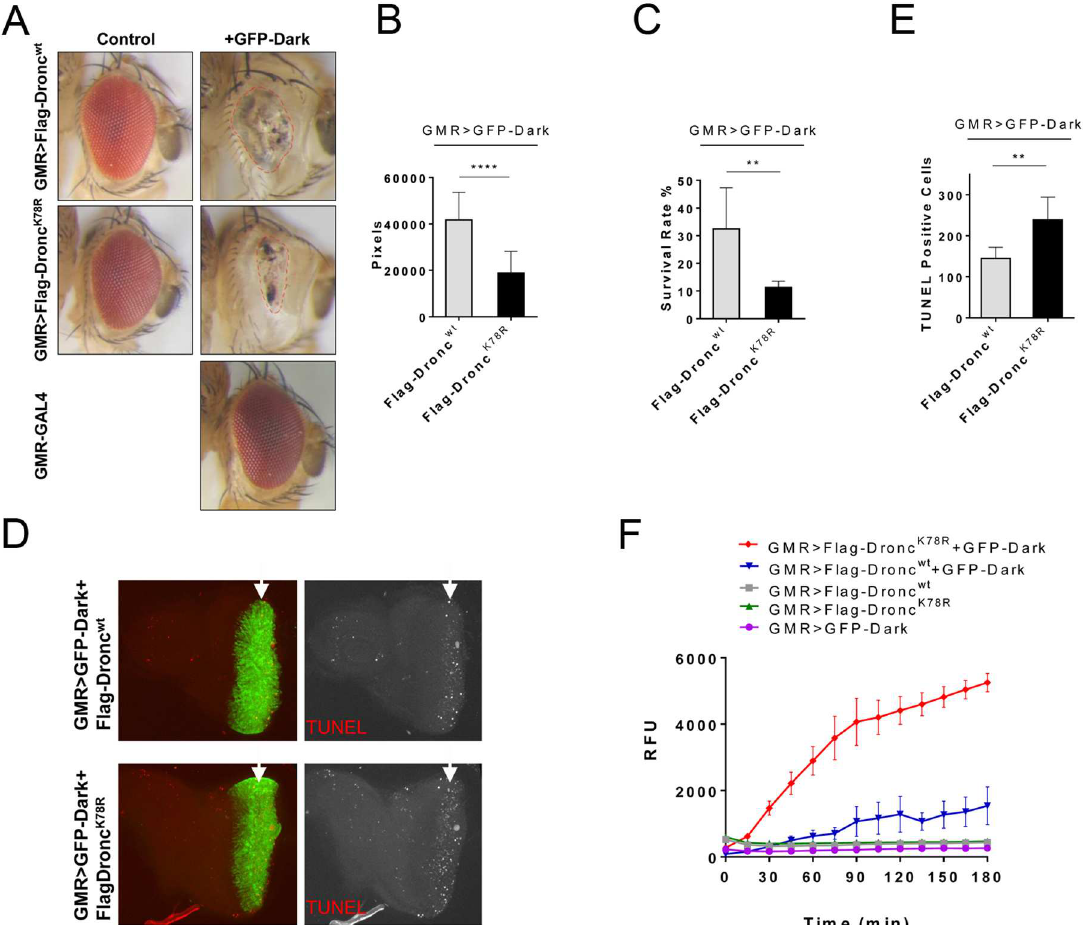
Fig 2. Loss of K78 ubiquitylation results in increased Dronc activity in the apoptosome. ( A-C ) Flag-Dronc K78R and GFP-Dark co-expression under GMR-Gal4 control results in significantly smaller eyes and a lower survival rate than GMR > Flag-Dronc wt +GFP-Dark . Controlflies just expressing GMR > Flag-Dronc wt , GMR > Flag-Dronc K78R or GMR > GFP-Dark alone,show wild type eye phenotype. (B) Quantification of the eye sizes in (A). n = 19 for GMR > Flag-Dronc wt + GFP-Dark ; n = 20 for GMR > Flag-Dronc K78R + GFP-Dark . (C) Quantificationof the reducedsurvival of GMR > Flag-Dronc K78R + GFP-Dark comparedto GMR > Flag-Dronc wt + GFP-Dark . ( D,E ) Significantly higherTUNEL labelingin the GMR -expression domain (arrows) of GMR > Flag-Dronc K78R + GFP-Dark comparedto GMR > Flag-Dronc wt + GFP-Dark eye imaginaldiscs of 3 rd instar larvae. GFP labels Dark. (E) Quantification of TUNEL positive cells in (D). n = 7 for both genotypes. ( F ) In vitro caspase activity assays of adult fly head extracts show significantly highercaspase activity with GMR > Flag-Dronc K78R + GFP-Dark towards Ac- DEVD-AMC substrate than GMR > Flag-Dronc wt + GFP-Dark . For quantifications, the student’s t-test was used. Error bars are SD. ** P < 0.01; *** P < 0,001; **** P <